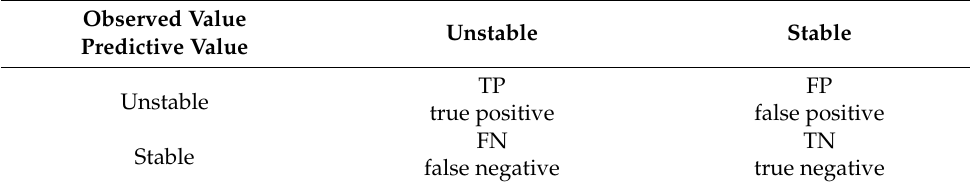
Table 19. Receiver operating characteristic curve evaluation